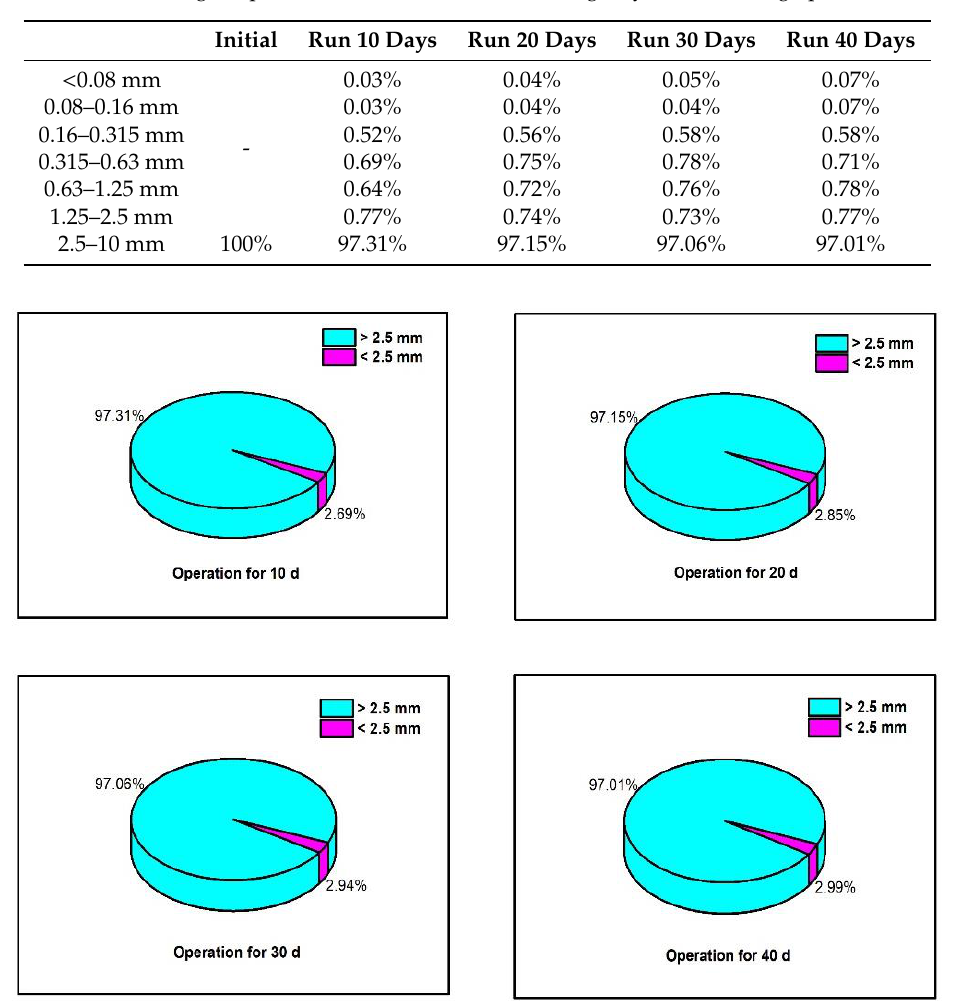
Figure 6. Change in particle size distribution of drainage layer filler during operation.